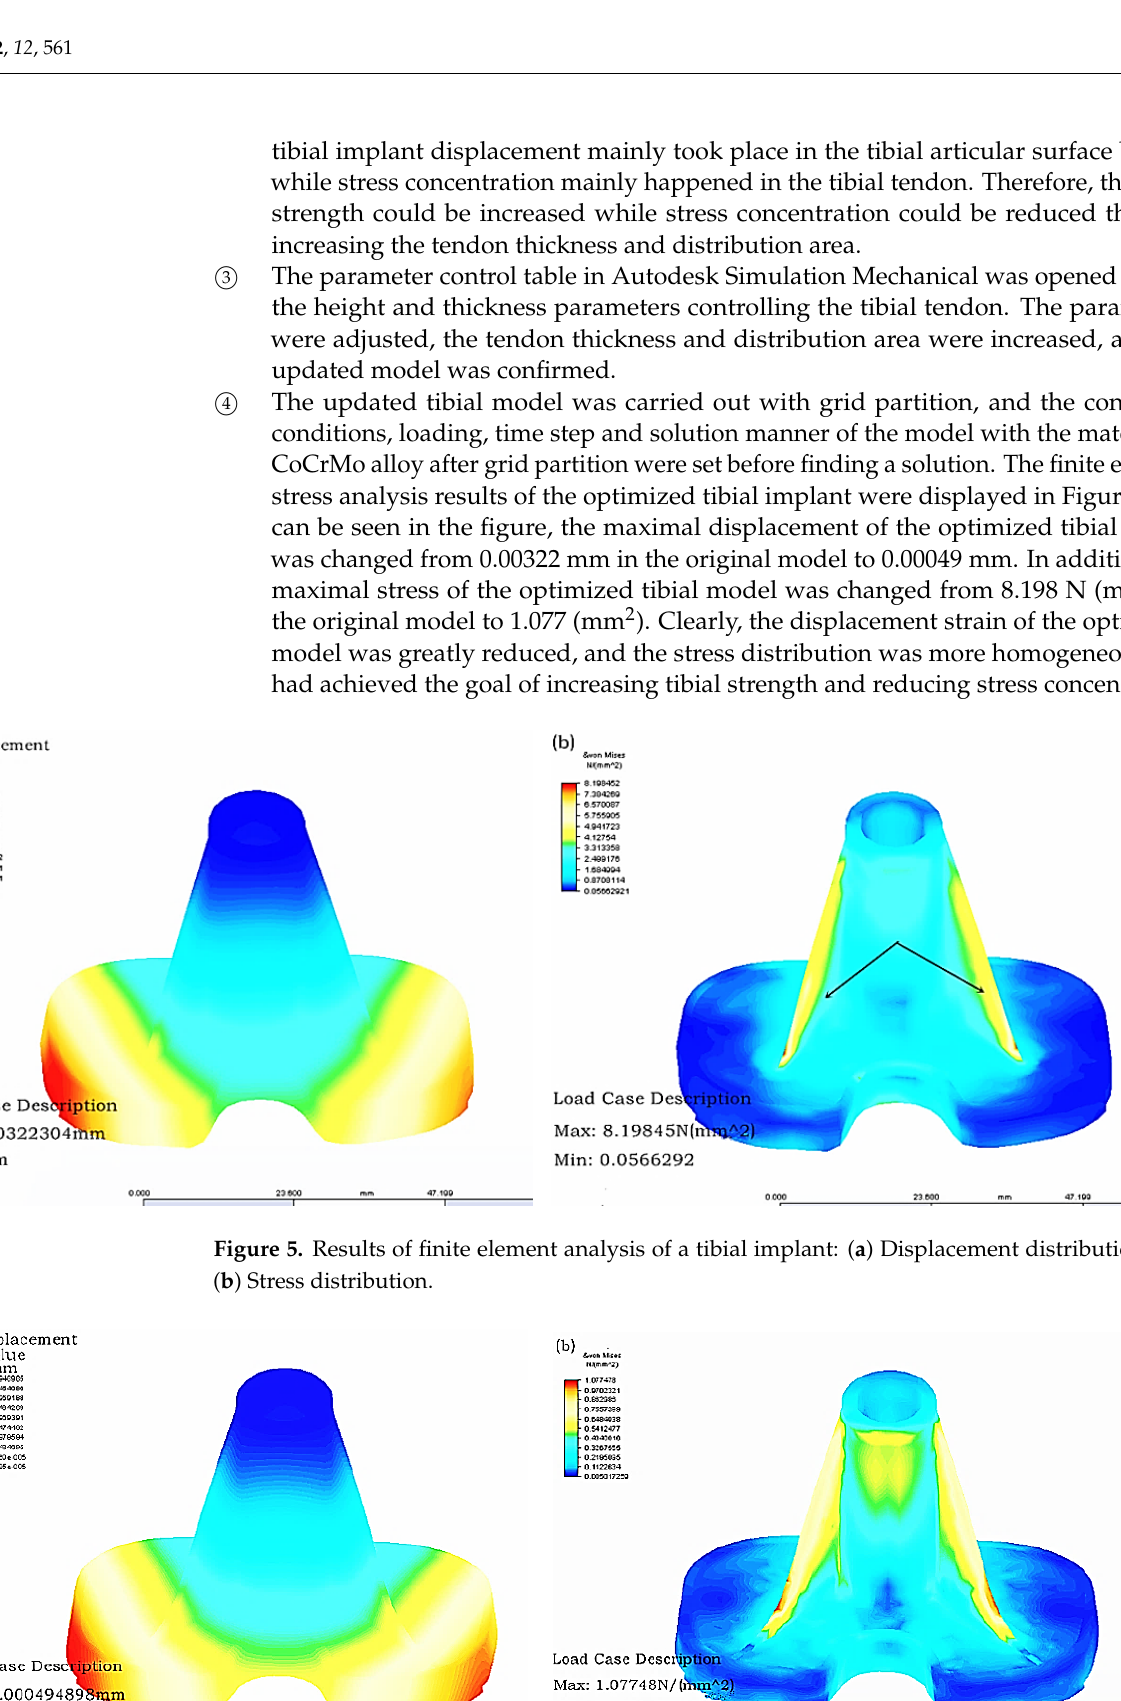
Figure 6. Optimization results of tibial implant: ( a ) Displacement distribution; and ( b ) Stress distribution.